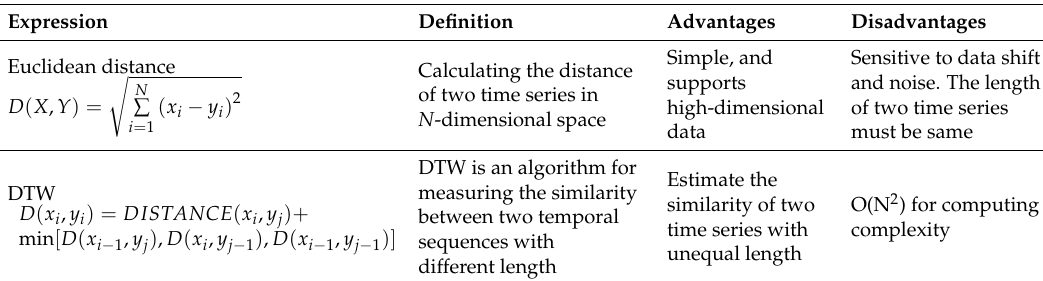
Table 1. Common similarity measure